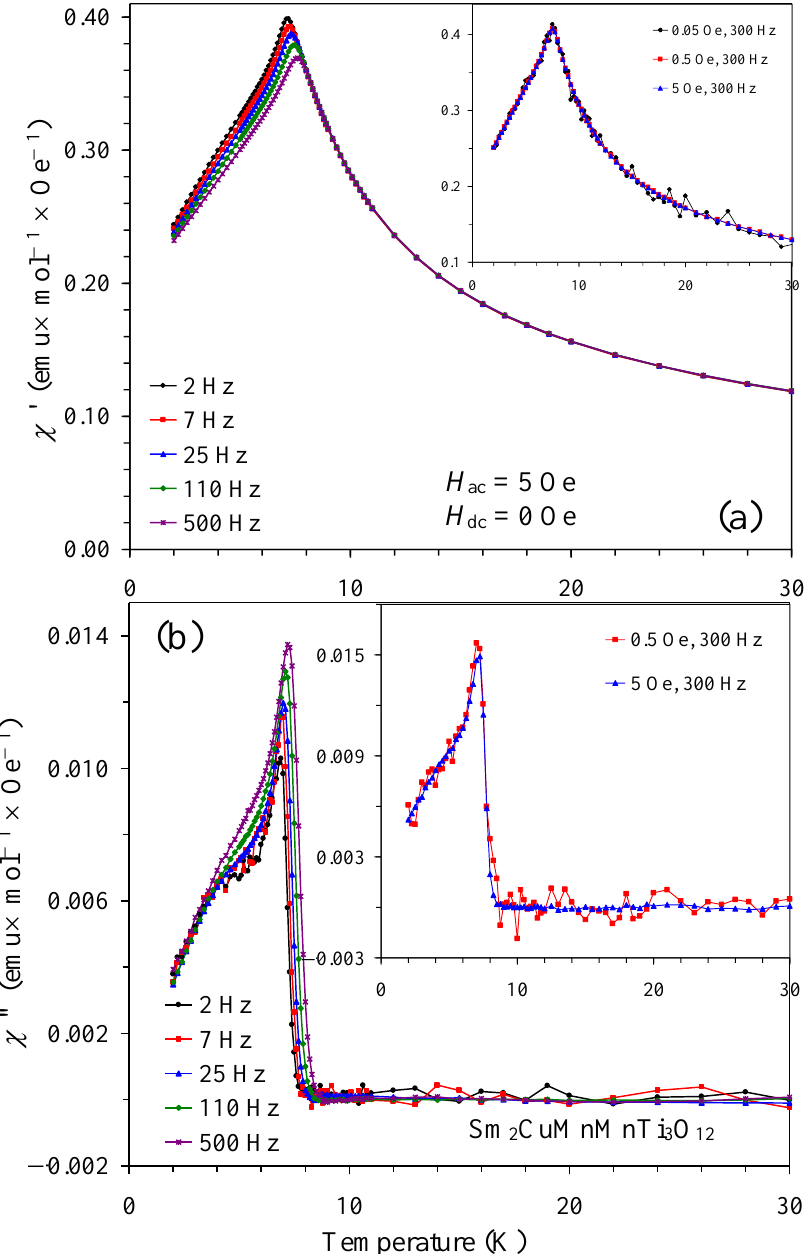
Figure 6. ( a ) Real ( χ′ ) and ( b ) imaginary ( χ″ ) parts of the ac magnetic susceptibility curves of Sm 2 CuMn(MnTi 3 )O 12 at different frequencies. The insets in ( a , b ) show the χ′ versus T and χ″ versus T curves at different H ac = 0.05, 0.5, and 5 Oe and one frequency ( f = 300 Hz) (the χ″ data at H ac = 0.05 Oe are not shown because they were too noisy).